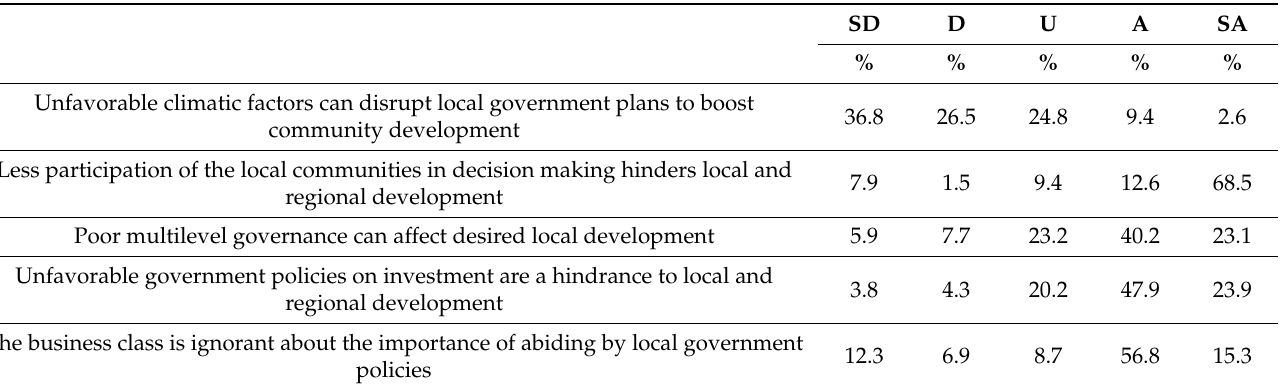
Table 3. Results on barriers to the effectiveness of local–regional management practices in enhancing local and regional